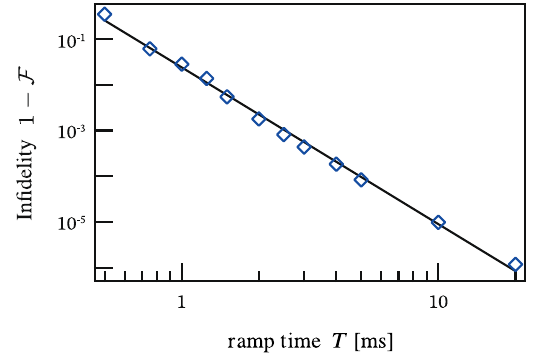
Fig. 7 In fi delity of the non-Abelian W.-Z. phase (1 (cid:1) F ) due to fi nite ramp time T . The non-Abelian W.-Z. phase factor is numerically evaluated by solving the time-dependent Schrödinger equation for our experimental condition for the path C (cid:3) with θ 2 = π / 4 and analyzed by following the same procedure used in the experiment to numerically obtain the process matrix. The solid line is a power-law fi t to the numerical results.